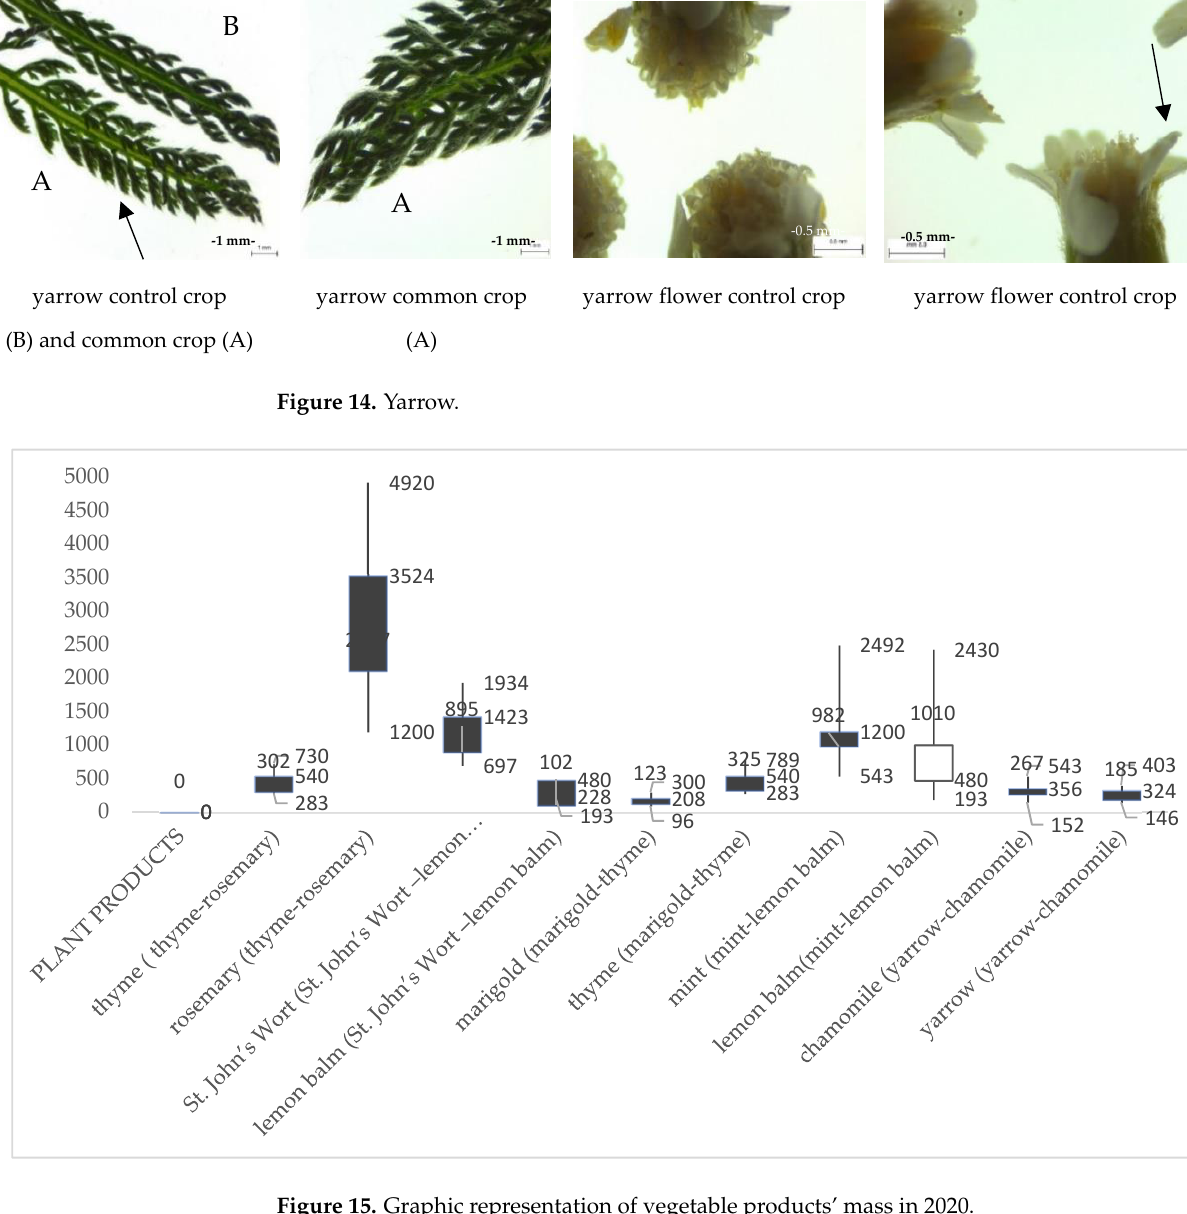
Figure 13. St. John ’ s Wort — Lemon Balm.